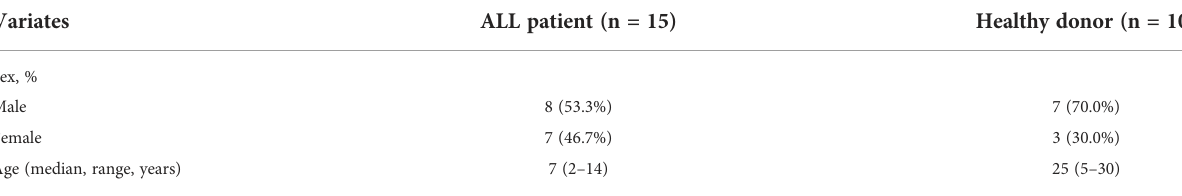
TABLE 1-1 Characteristics of ALL patients and healthy donors. Variates